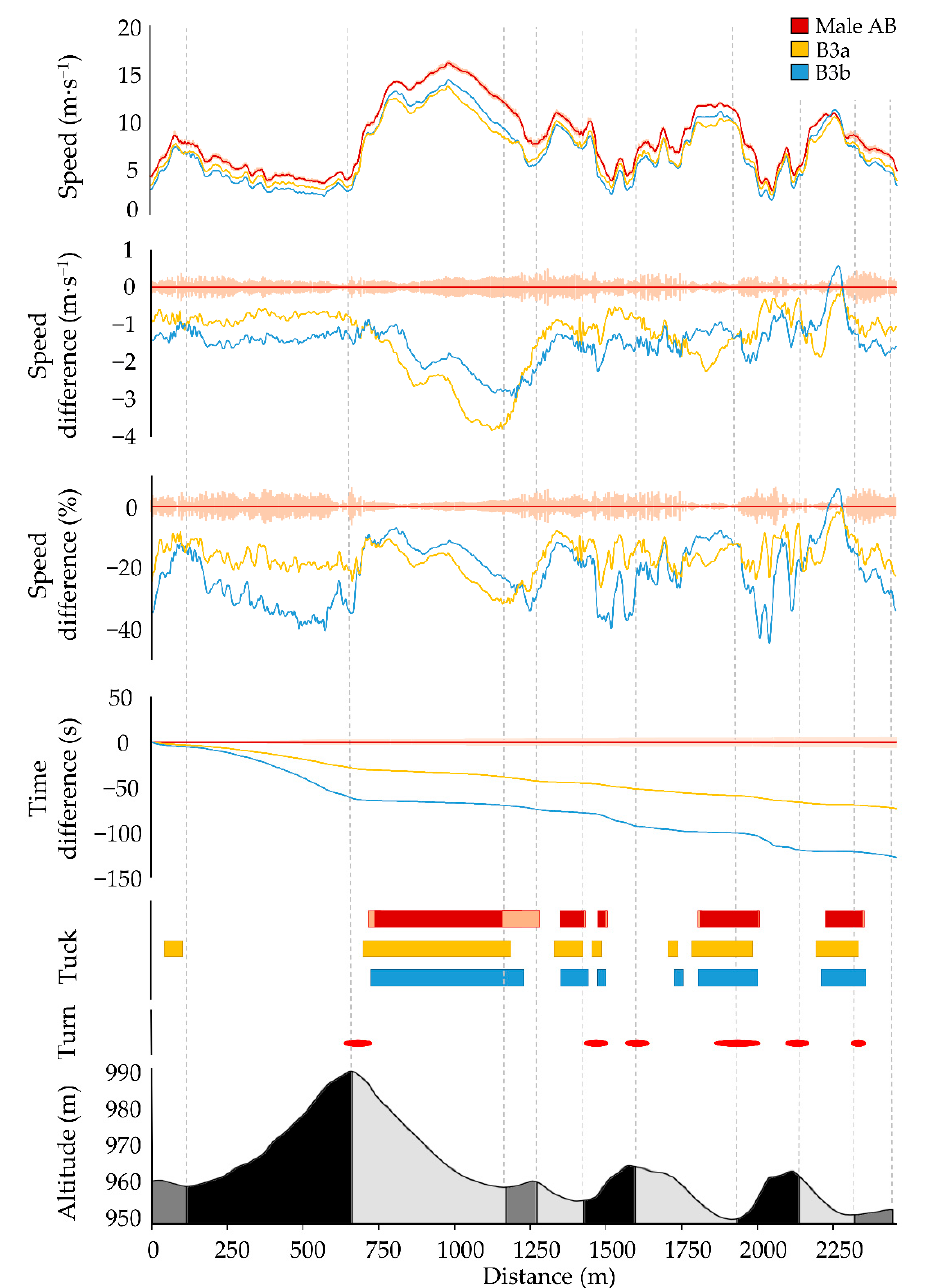
Figure 2. Comparison of average male AB XC skiers (dark red; standard deviation light pink), male B3a XC skier (yellow), and male B3b XC skier (blue) for the six laps during the race with respect to average speed, absolute speed difference, relative speed difference, accumulated time difference, and tuck. Course details are visualized in the lower part of the figure; turns (red dashes) and altitude profile of the 2.5 km race course, with uphill (black), flat (dark gray), and downhill (light gray) seg- ments.